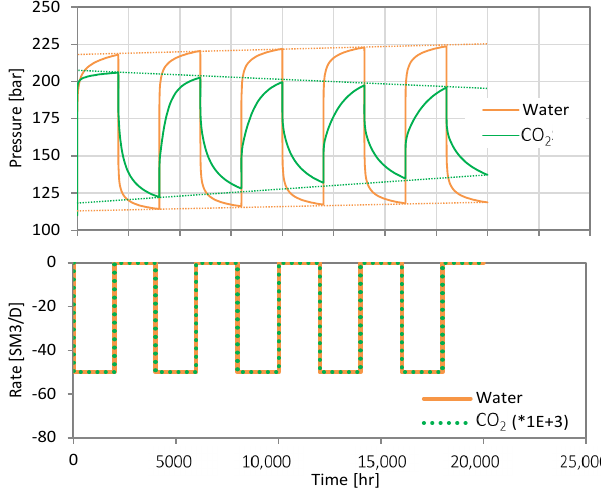
Figure 4. Well bottom hole pressure as a response to five sequential injection and shut-in periods (with cycle half-length of 83 days). The same reservoir model (Figure 2) was used following the simulations presented in Figure 3.